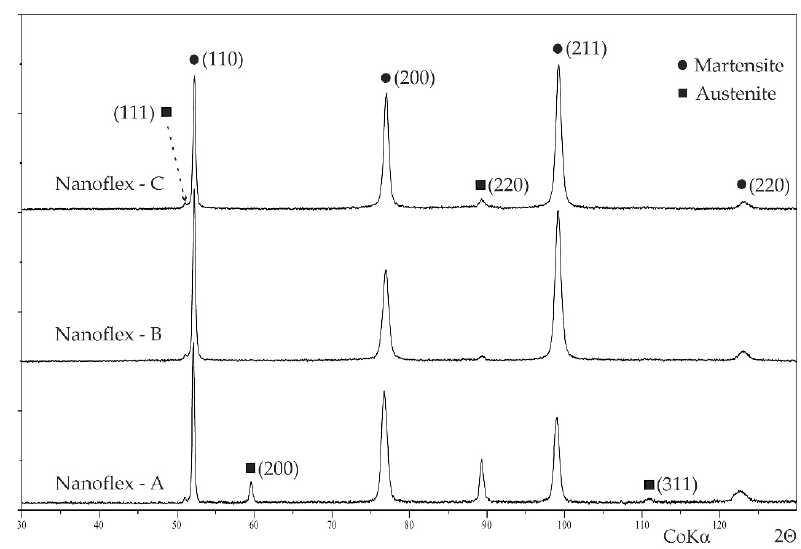
Figure 1. XRD patterns acquired from Nanoflex steel under various technological conditions. Results of thickness measurements are presented in Figure 2. It is clearly visible that,